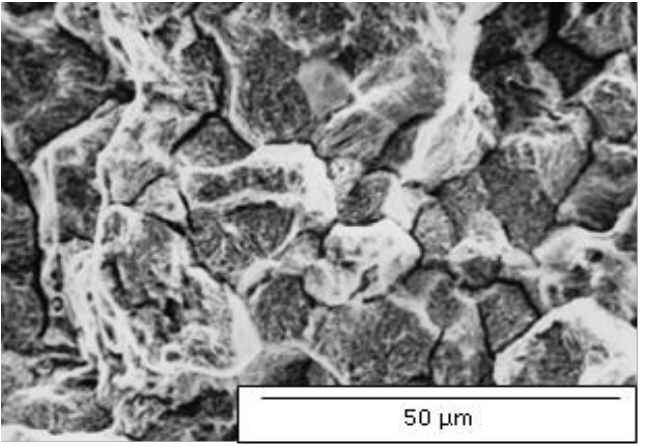
Figure 4. Intergranular brittle fracture of the 316L steel.